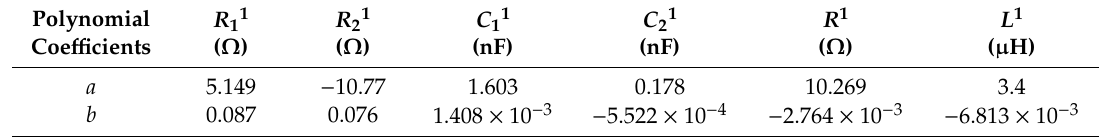
Table 6. Linear parameters for MT3 pi-circuit as a function of soil resistivity.